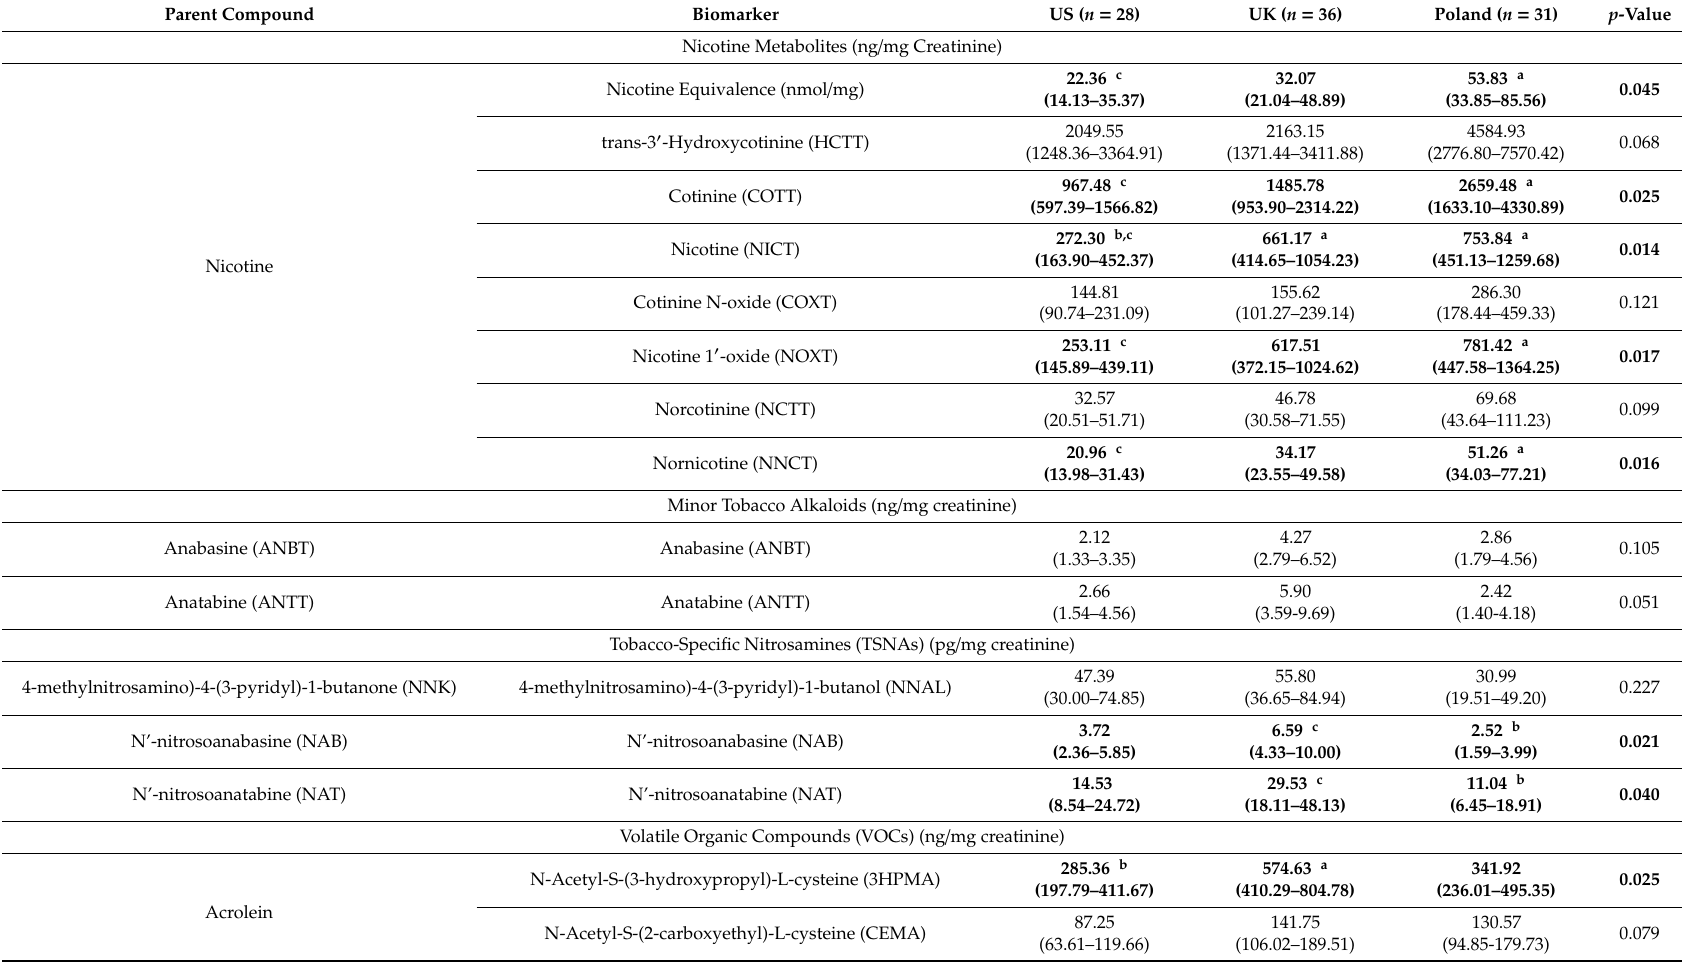
Table 3. Biomarkers of exposure to nicotine and selected toxicants in urine of dual users ( n = 95) from USA, UK, and Poland (normalized for creatinine; geometric means, 95% confidence